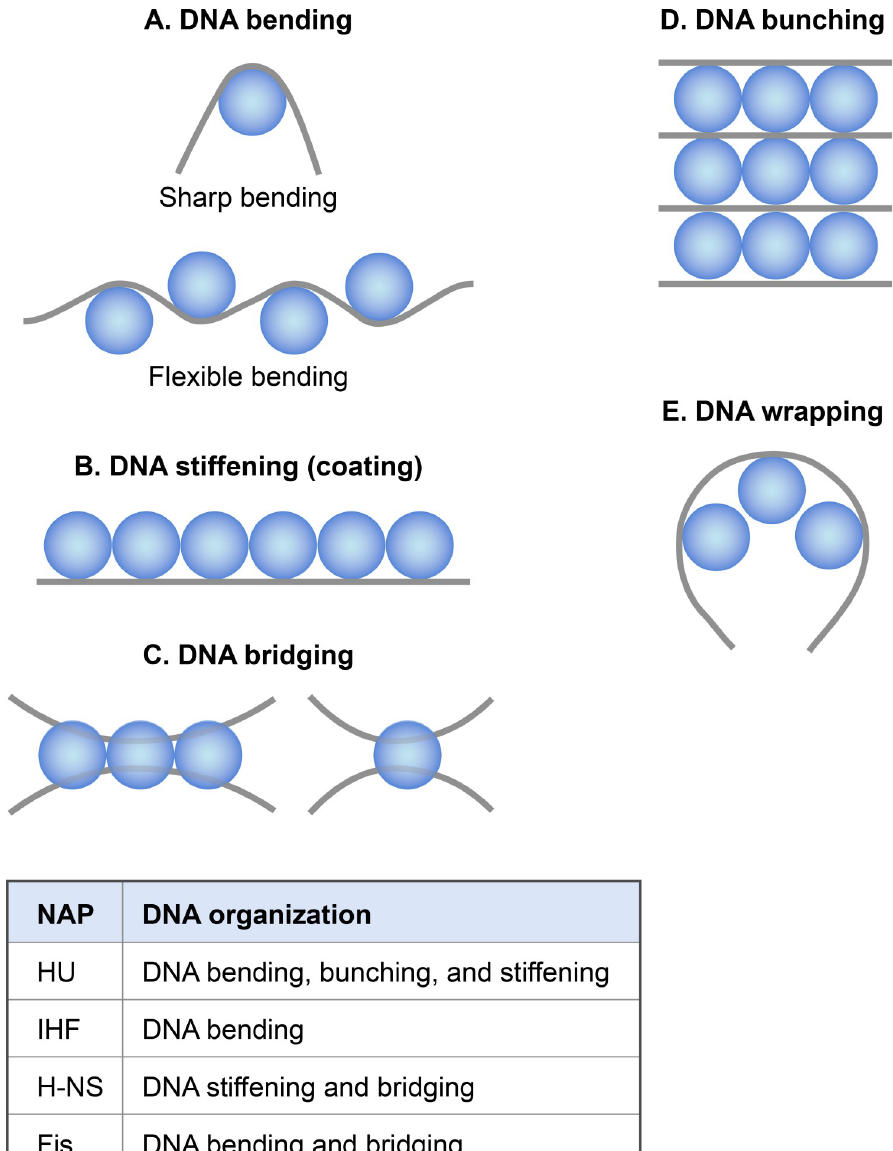
Fig 2. Nucleoid at � 1 kb scale. DNA organization by nucleoid-associated proteins (NAPs). A straight or curved grey line depicts DNA, and blue sphere depicts a NAP. A. NAPs organize DNA by bending it. For example, IHF causes sharp DNA bending (bending angle > 160˚) upon binding to a specific site, whereas HU introduces flexible bends (bend angles vary between 10–180˚). IHF also induce flexible bends at non-sequence-specific sites similar to those induced by HU. Fis bends DNA between 60–75˚ angle. B. In contrast to bending, NAPs can also cause straightening or stiffening of DNA. For example, H-NS spreads along DNA, and as a result, DNA becomes stiff. HU also causes stiffening of DNA at high concentrations ( μ m range). C. Simultaneous binding of a contiguous tract of NAP molecules (left) or a single NAP molecule (right) to a pair of adjacent or distant DNA sites results in DNA bridging. In an example of DNA bridging, a tract of laterally-bound H-NS molecules bridges two adjacent DNA sites. D . DNA bunching or bundling refers to DNA organization in which lateral multimerization of HU triggered by the non- sequence-specific binding brings several parallel DNA segments together, like in a bunch of flowers. E. NAP molecules bound adjacent to each other can wrap DNA by coherent bending. Fis molecules bound at tandem sites may organize DNA in this